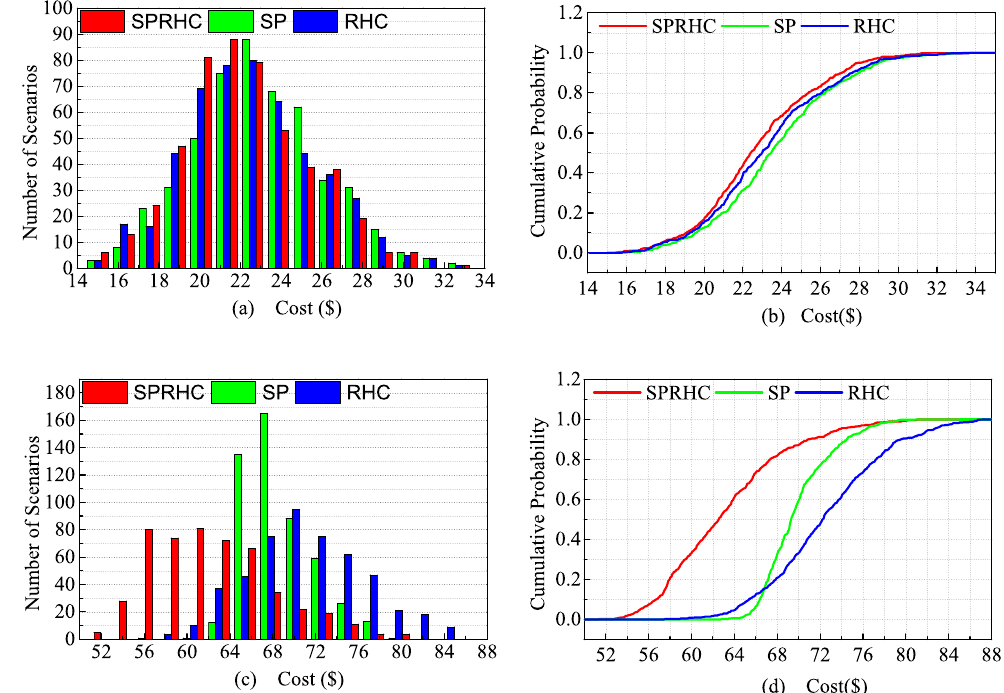
Figure 10. Probability distribution function (PDF) and cumulative distribution function (CDF) of MG total operating cost with SP, RHC and SPHC strategy ( a ) PDF in grid-connected mode; ( b ) CDF in grid-connected mode; ( c ) PDF in island mode; ( d ) CDF in island